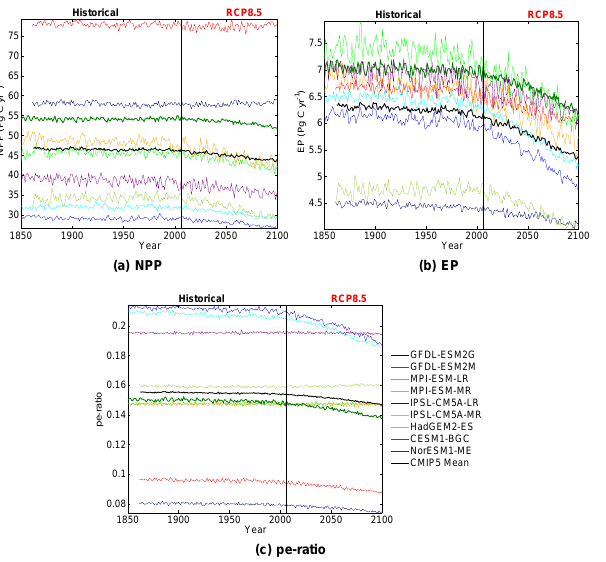
Figure 5. Time series of global mean net primary production, export production and the particle export ratio over 1850–2100 are shown for each model.